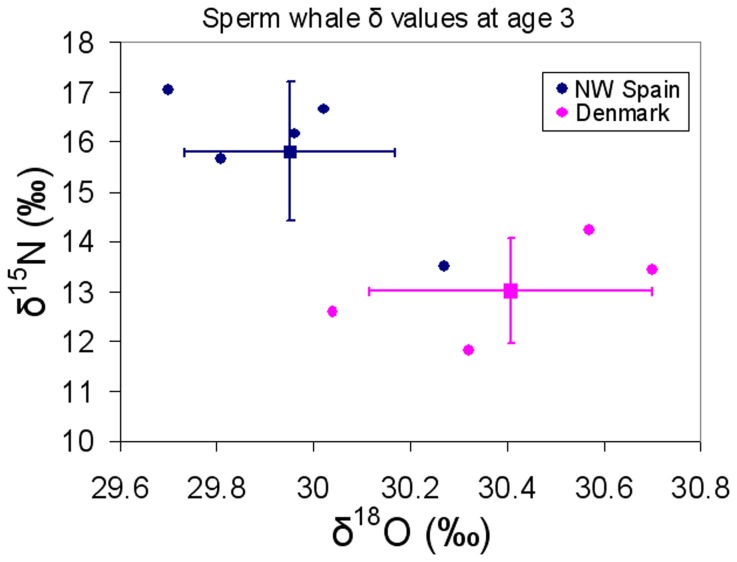
Comparison of δ15N and δ18O values (mean±sd) of the 3rd year dentinal growth layer group (GLG) in sperm whales sampled in Denmark (n=4) and NW Spain (n=5) (p<0.05 for δ15N; and p<0.01 for δ18O).